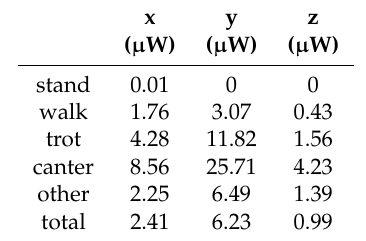
Table 2. The average values for the harvested energy are the highest in the y-direction and reaches up to 25.71 µ W of average harvested power during canter. The total datasets averages at 6.23 µ W for the y-direction of the sensor. x y z ( µ W) ( µ